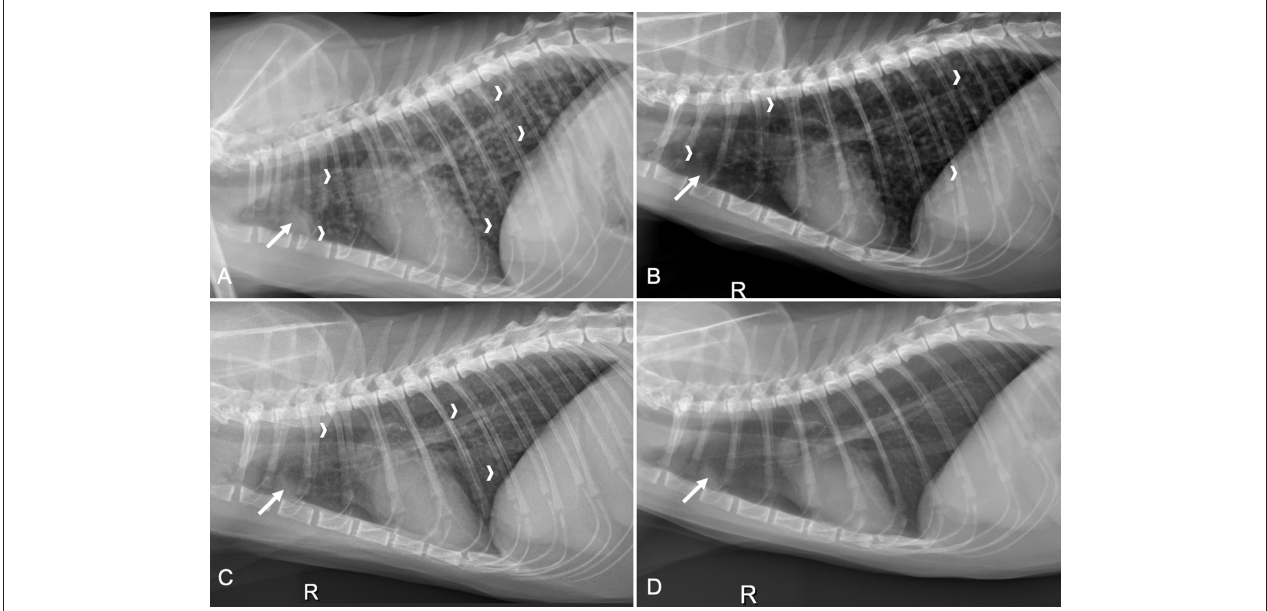
FIGURE 1 | Four right lateral thoracic radiographs obtained from a cat with a compressive Coccidioides spp. spinal granuloma from initial presentation and three time points after decompressive neurosurgery and fluconazole therapy. (A) Earliest study performed on initial presentation, before surgery, revealed a miliary pulmonary pattern with numerous small soft tissue nodules (white chevrons) in all lung lobes and sternal lymphadenomegaly (solid white arrow); (B) On day 35 there were fewer pulmonary nodules (white chevrons) and the sternal lymphadenomegaly remained static (solid white arrow); (C) Three months later (day 140), there were even fewer pulmonary nodules (white chevrons) and the sternal lymphadenomegaly remained relatively static (solid white arrow); (D) Six months following images in C (day 310), there was resolution of the pulmonary nodules and the sternal lymphadenomegaly was static (solid white arrow).